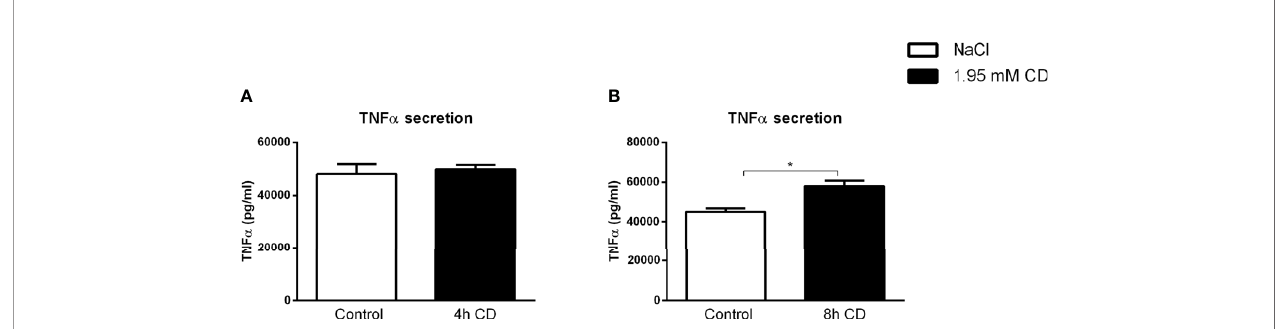
FIGURE 5 | RAW cell line-related parameters of in fl ammation after prolonged exposure to 2-hydroxypropyl- b -cyclodextrin. (A, B) TNF a protein levels of 2- hydroxypropyl- b -cyclodextrin (1.95 mM; 4 or 8hr)-treated RAW cells that were terminally stimulated with LPS (100ng/ml; 4hr). Data represent n = 3 for each experimental group. * indicates p < 0.05 by means of unpaired t-test.